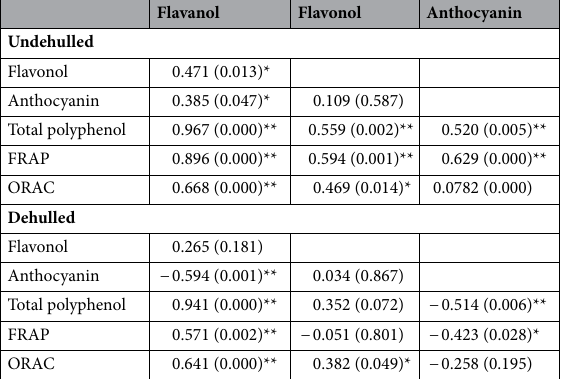
Table 3. Bivariate correlation between the phytochemicals and antioxidant activity of Bambara groundnut. Correlation coefficient and p-value in bracket. Correlation is significant at the 0.05 level (*) and 0.01 level (**)